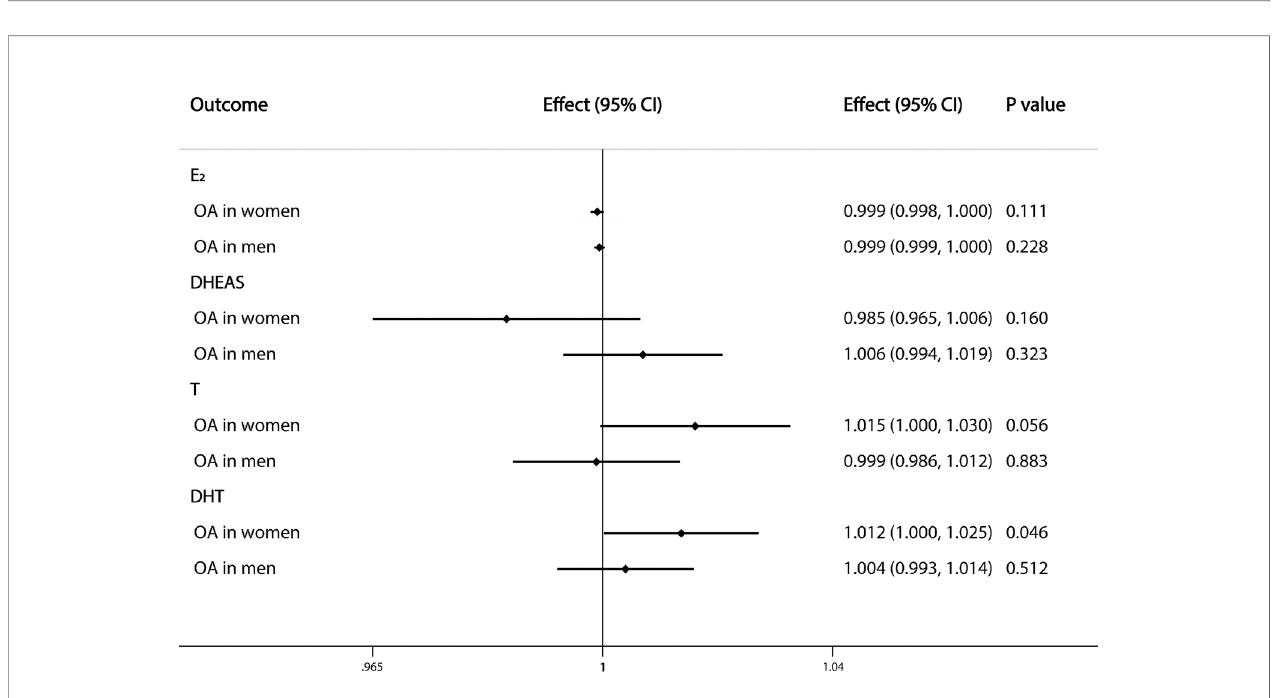
FIGURE 2 | Causal effects of sex steroids on the risk of OA of hip and knee. The estimated effects, 95% con fi dence intervals and p-values of associations were contained. Effect, the combined causal effect; CI, con fi dence interval; P value, p-value of the causal